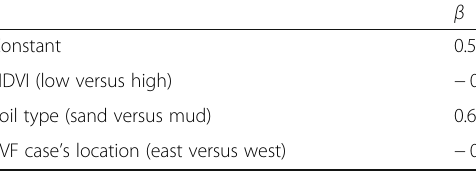
Table 1 Summary of regression model coefficient β Std. error T